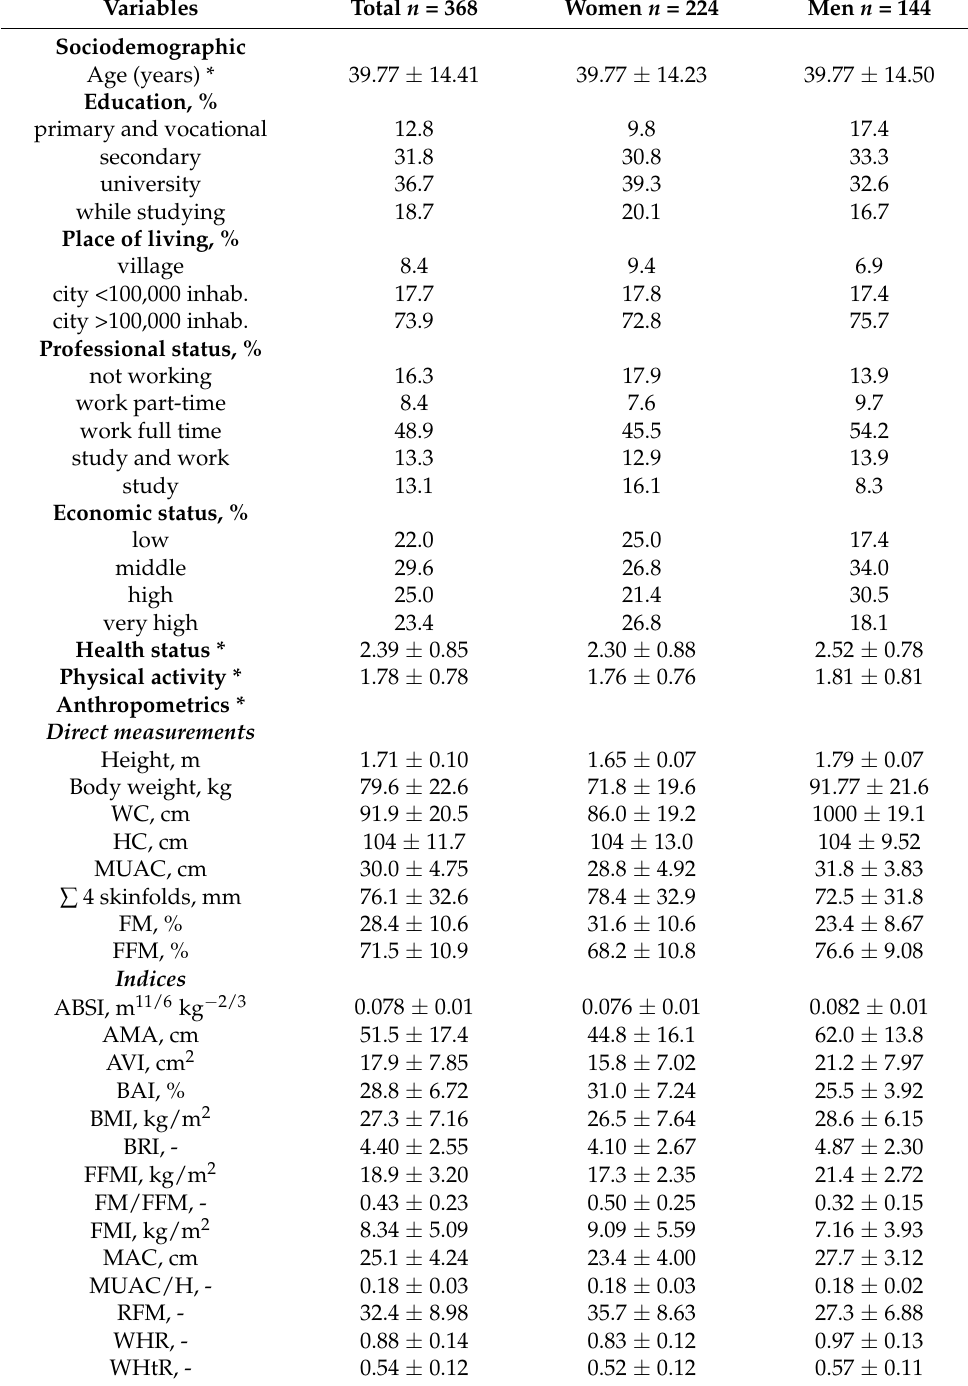
Table 1. Characteristics of the participants (Mean ± SD or